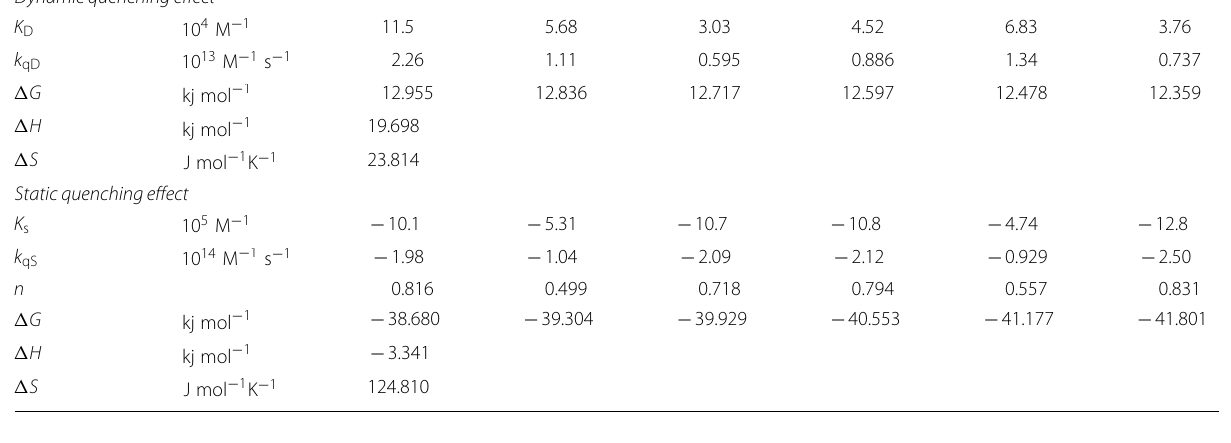
Table 1 Thermodynamic and kinetic parameters of insulin and resveratrol interaction Parameter